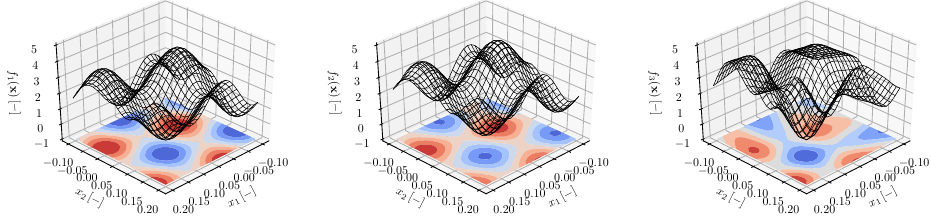
Figure 4. Shifted-rotated Rastrigin function (from left to right, high-, medium-, and low-fidelity).